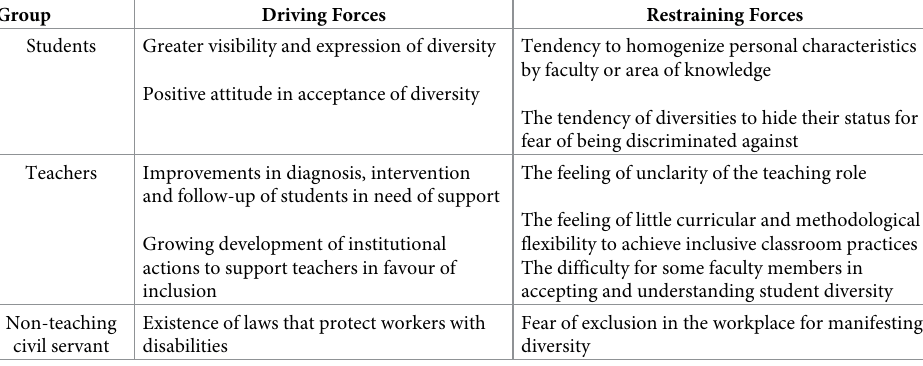
Table 3. Driving and restraining forces by